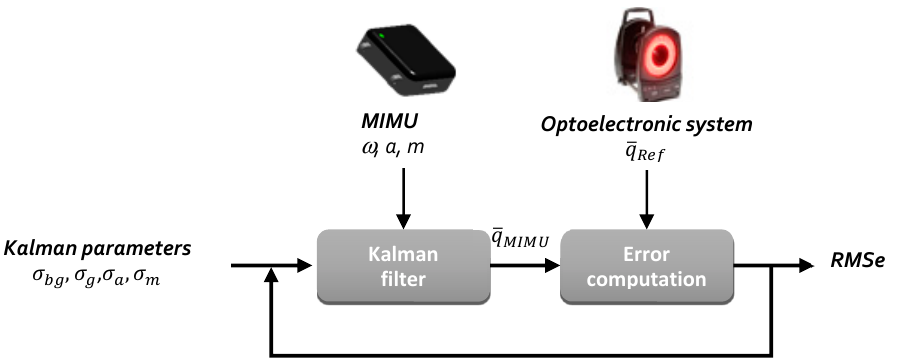
Figure 3. Identification process. MIMU: magneto-inertial measurement units; RMSe : root mean squared error.